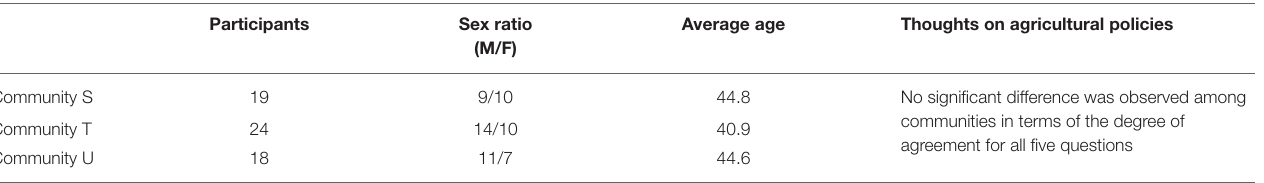
TABLE 1 | Attributes of community